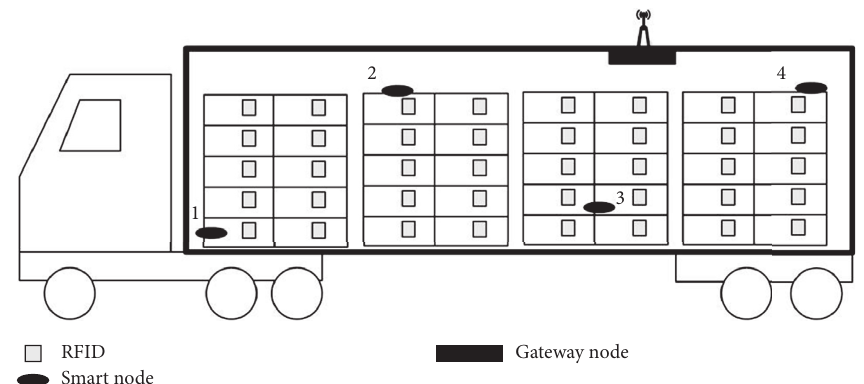
Figure 1: Schematic diagram of refrigerated truck monitoring.